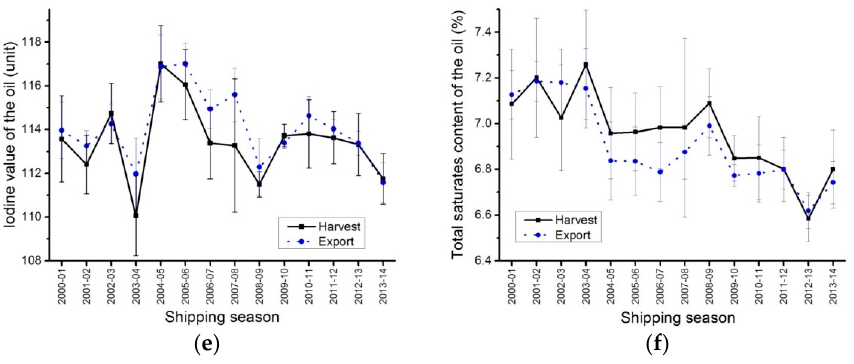
( f ) Figure 6. Oil quality, oleic acid, linoleic acid, α -linolenic acid, erucic acid, iodine value and total saturate content averages, harvest (HSD) and export (ECD) samples of Canada No. 1, Canola from 1 August, 2000 to 31 July, 2014. ( a ) oleic acid content averages (%); ( b ) linoleic acid content averages (%); ( c ) α -Linolenic acid content averages (%); ( d ) erucic acid content averages (%); ( e ) iodine value (units) averages; ( f ) total saturates content averages (%). Table 5. Yearly mean average and standard deviation for harvest (HSD) and exports (ECD) of samples of Canada No. 1, Canola for oleic, linoleic, α -linolenic and erucic acid contents of the oil. Oleic Acid Content of the